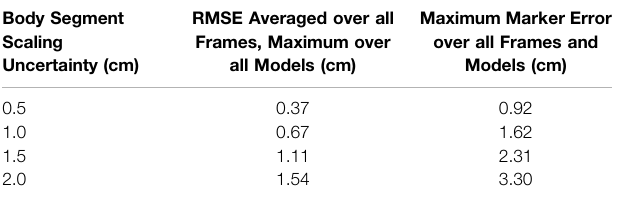
TABLE 2 | The effect of body segment scaling uncertainty on marker errors (with respect to the locations of the markers on the original model) from IK for varying levels of uncertainty.